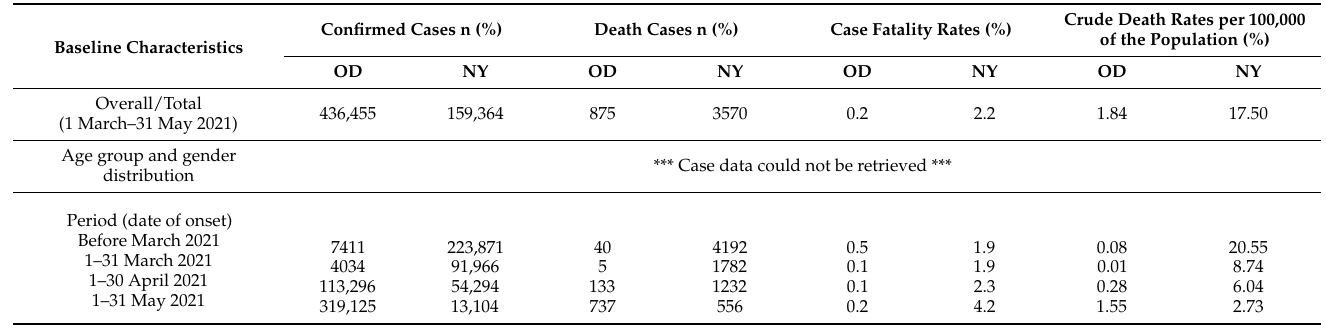
Table 2. Baseline characteristics for confirmed and death cases of COVID-19 as well as case fatality rates and crude death rates in the state of New York and Odisha from 1 March 2021 to 31 May 2021. A total of 159,364 confirmed and 3570 death cases were reported in NY, and 436,455 confirmed and 875 death cases were reported in OD. The ‘Overall/Total’ row includes the cumulative data from 1 March 2021 to 31 May 2021. The ‘Before March 2021’ row includes cumulative data of January and February 2021. Abbreviations: OD, State of Odisha, India. NY, State of New York,